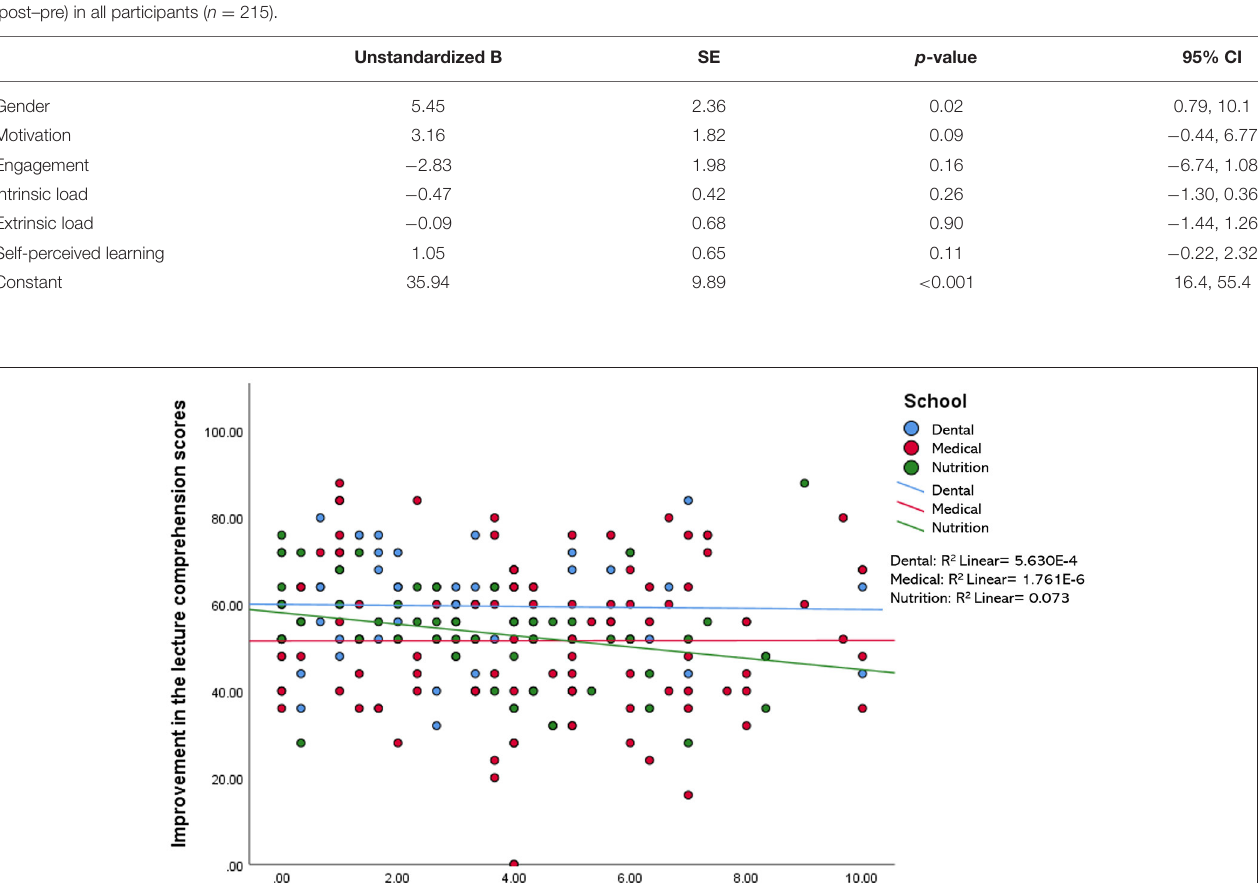
TABLE 3 | Influence of gender, motivation, engagement, intrinsic load, extrinsic load, and self-perceived learning in the change of CLT-based online lecture scores (post–pre) in all participants ( n = 215).